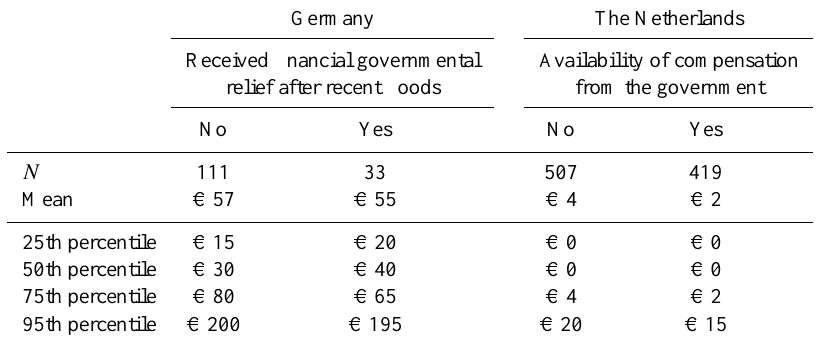
Table 5. Comparison of the WTP for flood insurance by households who received or did not receive governmental compensation for flood damage in Germany and Dutch private households, who can obtain or cannot obtain governmental compensation for flood